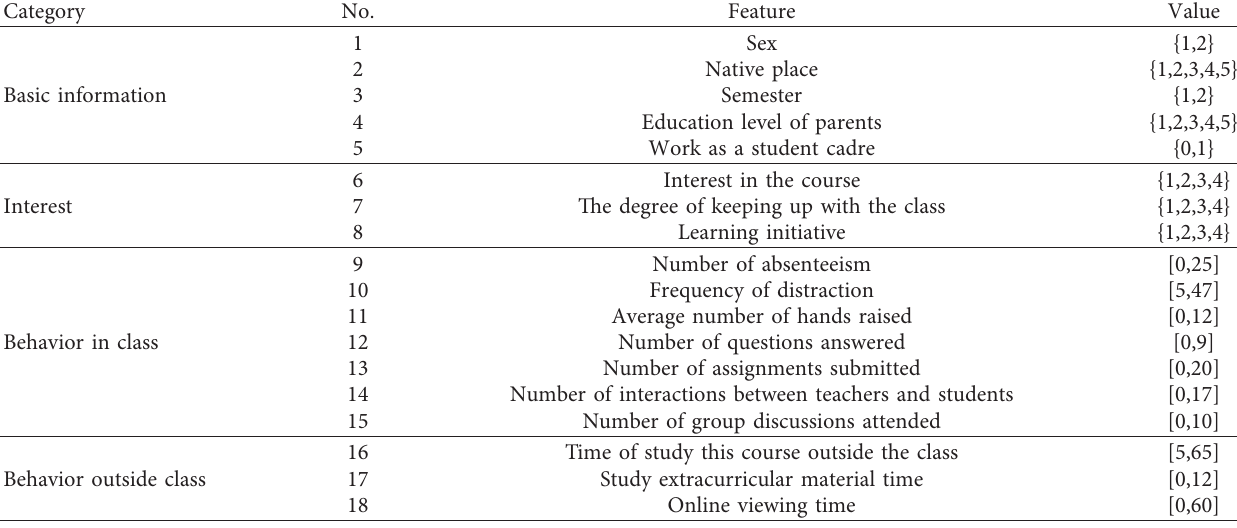
Table 3: The features of each student sample.